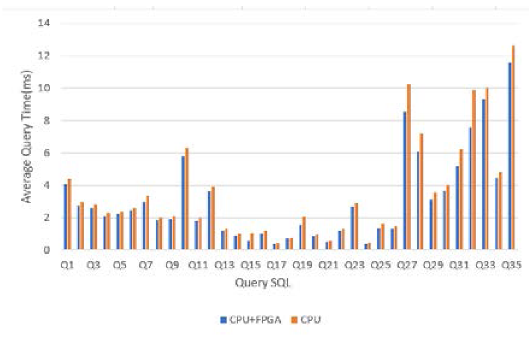
Fig. 6. Average Query time comparison